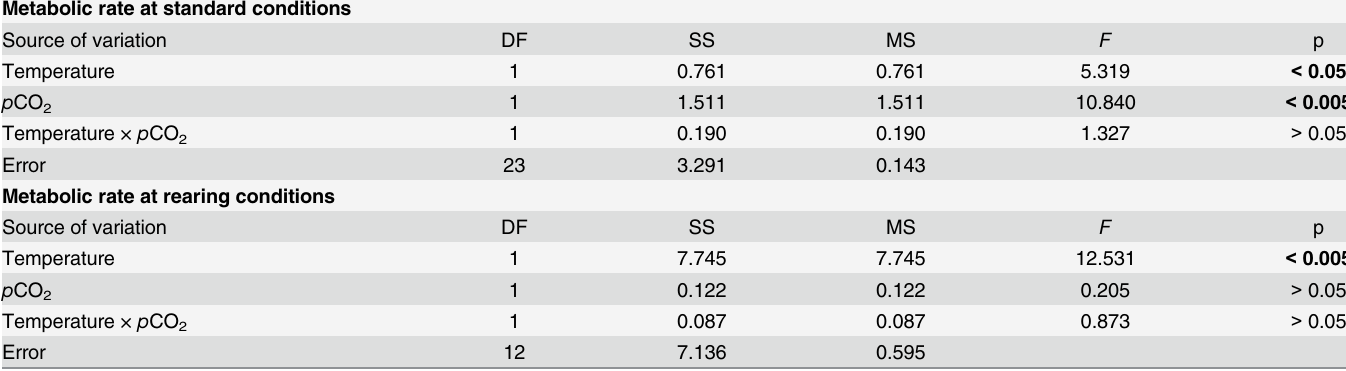
Table 6. Concholepas concholepas. Two-way ANOVAs investigating the effect of different combinations of temperature (15 and 19°C) and p CO 2 (500 and 1400 μ atm) levels on the metabolic rate measured in small juveniles after 4.8 and 5.8 months of rearing in the experimental conditions (Fig 4a and 4b). Values in bold are significant at p < 0.05. Data for metabolic rate under standard conditions was log transformed, and data for metabolic rate under treatment conditions were rank